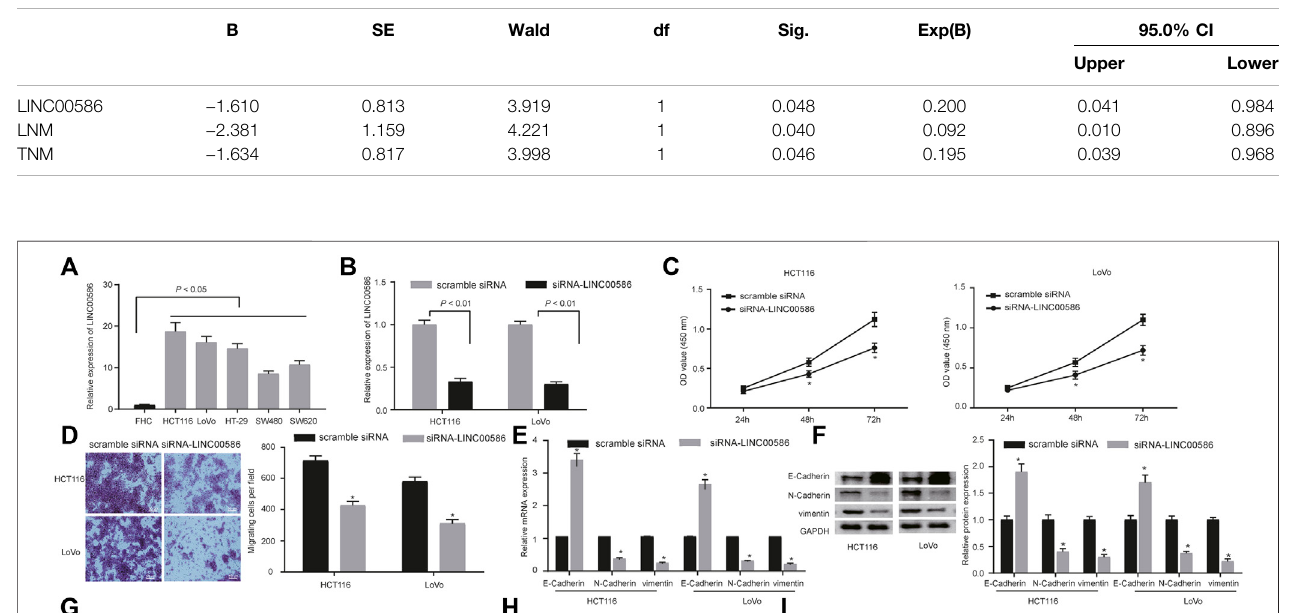
tissues was used to classify 54 CRC patients with high or low expression of LINC00586. The Kaplan-Meier curve was depicted to show CRC patient prognosis according to LINC00586 patients.